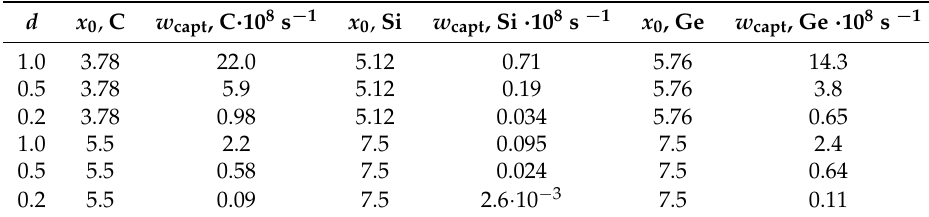
Table 3. Estimate of the formation rate of ionized acceptor centers ( µ A ) − in the C, Si and Ge